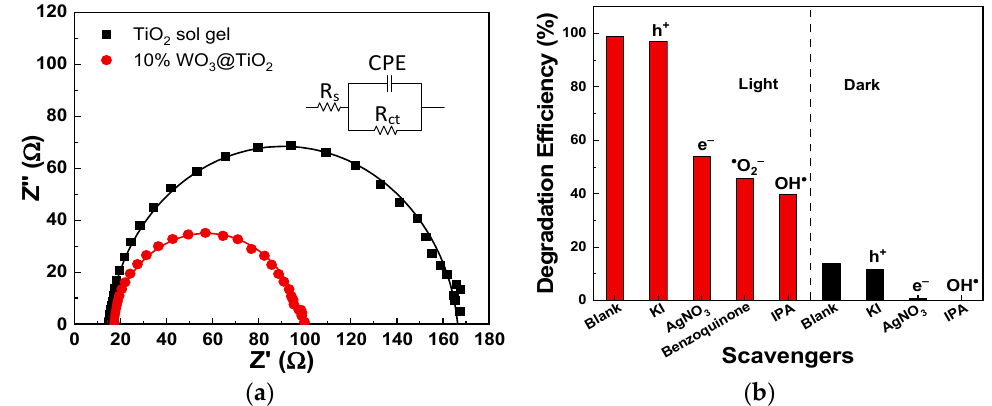
Figure 6. EIS spectra (Nyquist plots) with the fitted circuit diagram of the neat TiO 2 (synthesized via sol–gel) and 10% WO 3 @TiO 2 ( a ); the effect of scavengers on photodegradation of methylene blue ( b ). To gain be tt er understanding of the charge transport mechanism in the composite metal oxides (10%WO 3 @TiO 2 ), an additional experiment was conducted by introducing (p − BQ), and isopropanol (IPA), into the system. The photodegradation of methylene blue